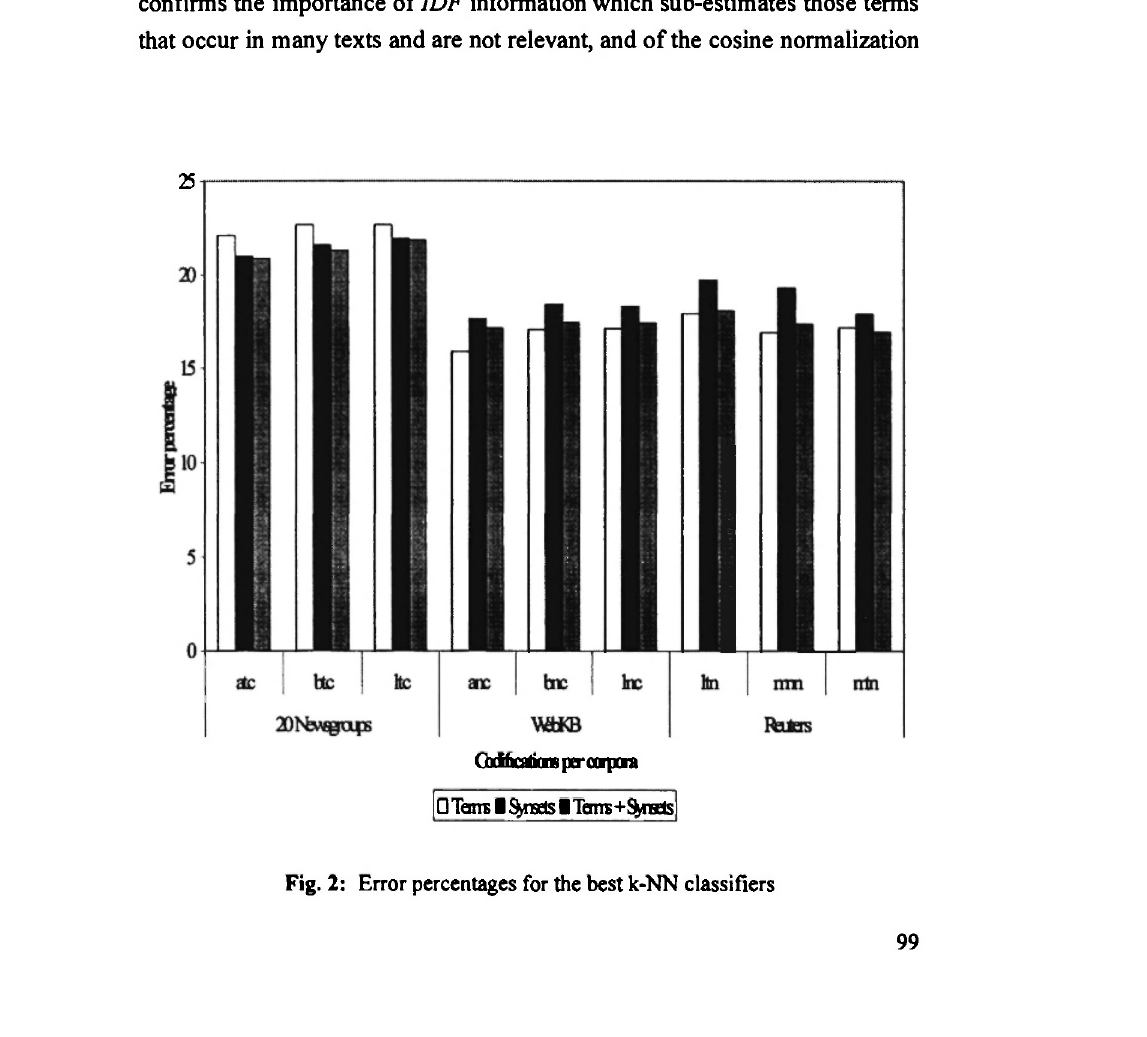
Fig. 2: Error percentages for the best k-NN